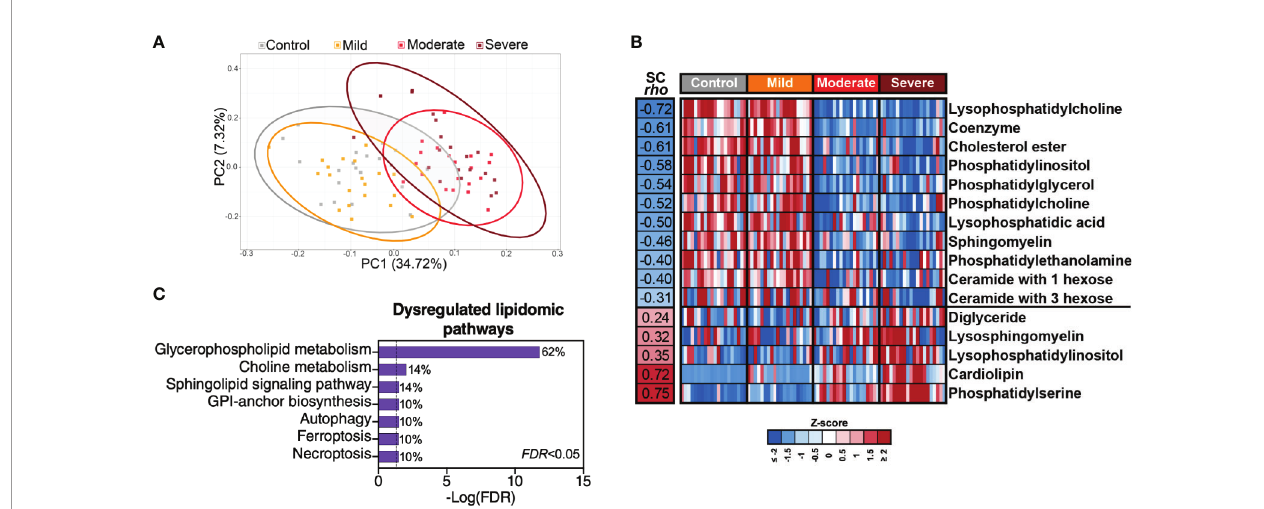
FIGURE 5 | Severe COVID-19 is associated with disrupted lipid metabolism. (A) Principal component analysis (PCA) of 2015 lipids identi fi ed in the plasma of the study cohort. (B) The 2015 identi fi ed lipids were assigned to 24 classes ( Supplementary Table 5 ). Heat-map depicts the 16 lipid classes dysregulated by severe COVID-19 (FDR<0.05). Statistical signi fi cance was determined using the Kruskal – Wallis test. FDR was calculated using Benjamini-Hochberg method. SC rho = coef fi cient of correlation with COVID-19 severity. Heat colors show standardized Z-scores across samples; red indicates upregulation, and blue indicates downregulation. (C) Lipid pathway analysis of the plasma lipids modulated between the disease states with FDR<0.05 was performed using LIPEA (Lipid Pathway Enrichment Analysis; https://lipea.biotec.tu-dresden.de/home). The graph includes all dysregulated pathways with FDR<0.05. Percentages beside each pathway represent the ratio of dysregulated lipids among the total number of lipids assigned to this particular pathway by